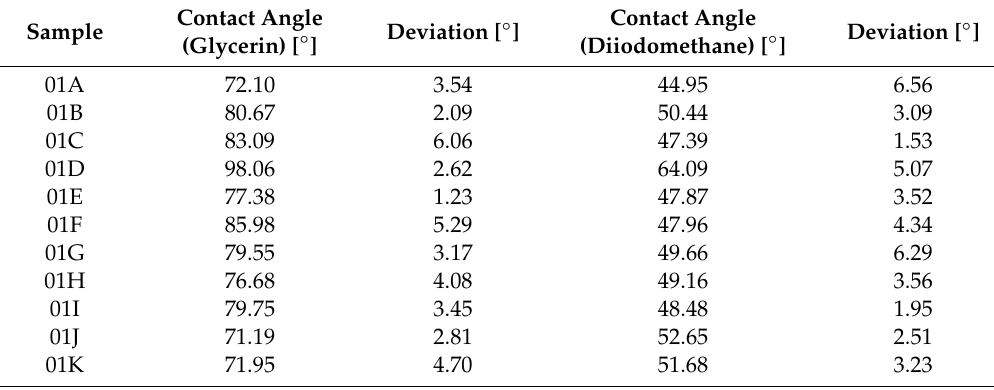
Table 6. Wetting angles of oxide coatings produced in the anodizing process (without thermo-chemical treatment) for glycerine and